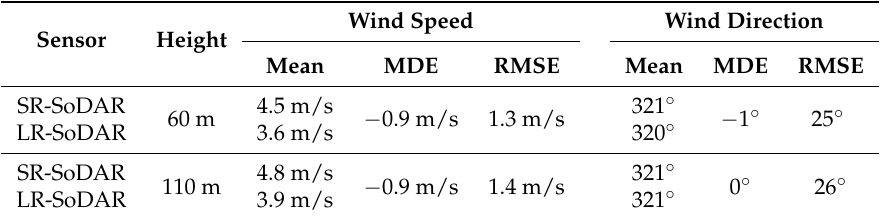
Table 9. Results from the comparison of SoDAR wind speed and wind direction observations collected from 15:00 to 20:30 EDT on 5 June